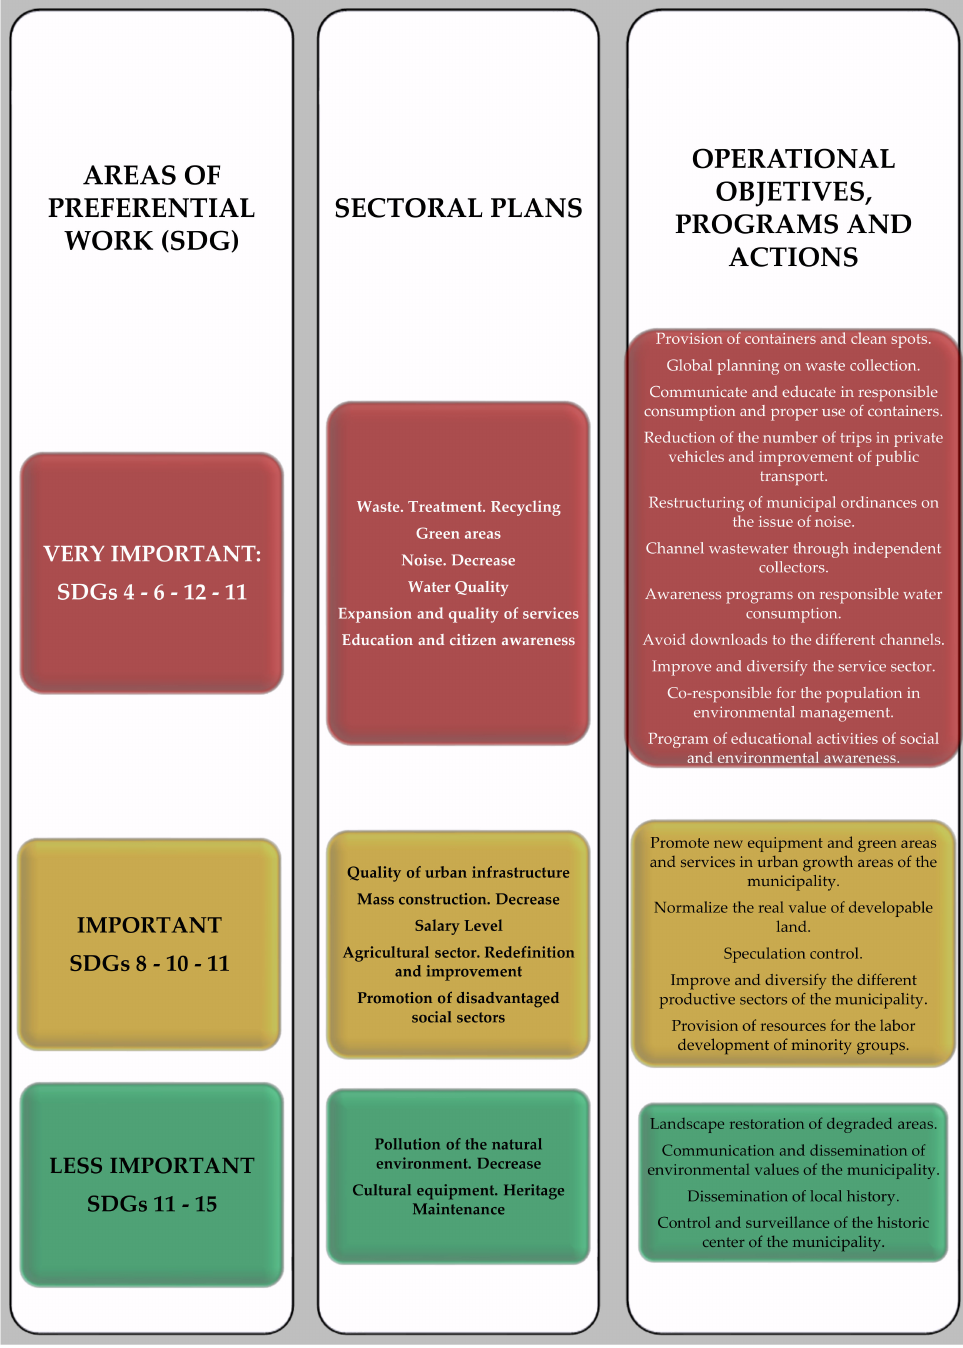
Figure 10. Perceived problems and SDGs. Triangulation (adaptation matrixed participatory process of Garcia-Ayllon, S, 2018